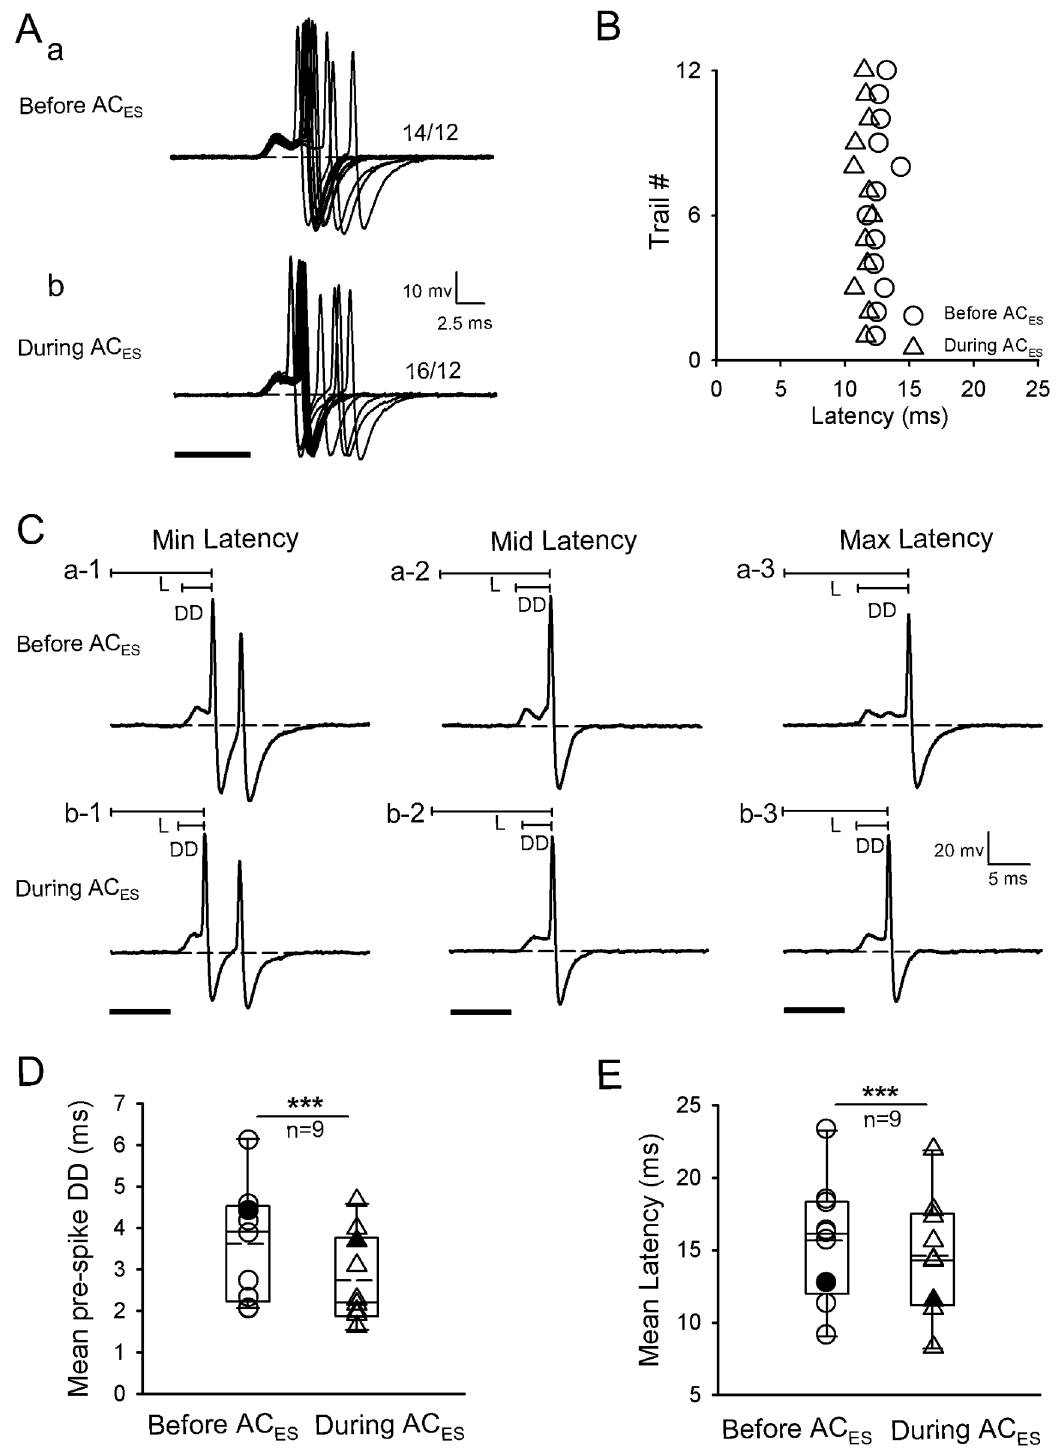
Fig 2. Representative facilitated IC neuron by AC ES showing its latency decreasing induced by pre-spike DD shortening. (A) Original responsetraces obtainedby 12 repetitive pure tone stimulationconditions before (Aa) and during(Ab) AC ES . (B) Distributionof latency values calculatedaccordingto Aa and Ab before (unfilledcircle) and during (unfilledtriangle)AC ES . (C) Three representative (i.e., minimum (a-1, b-1), middle (a-2, b-2), and maximum (c-1, c-2)) latencies(L) selectedfrom Aa and Ab before (Ca-1–a-3) and during (Cb-1–b-3) AC ES . (D) Comparisonof mean